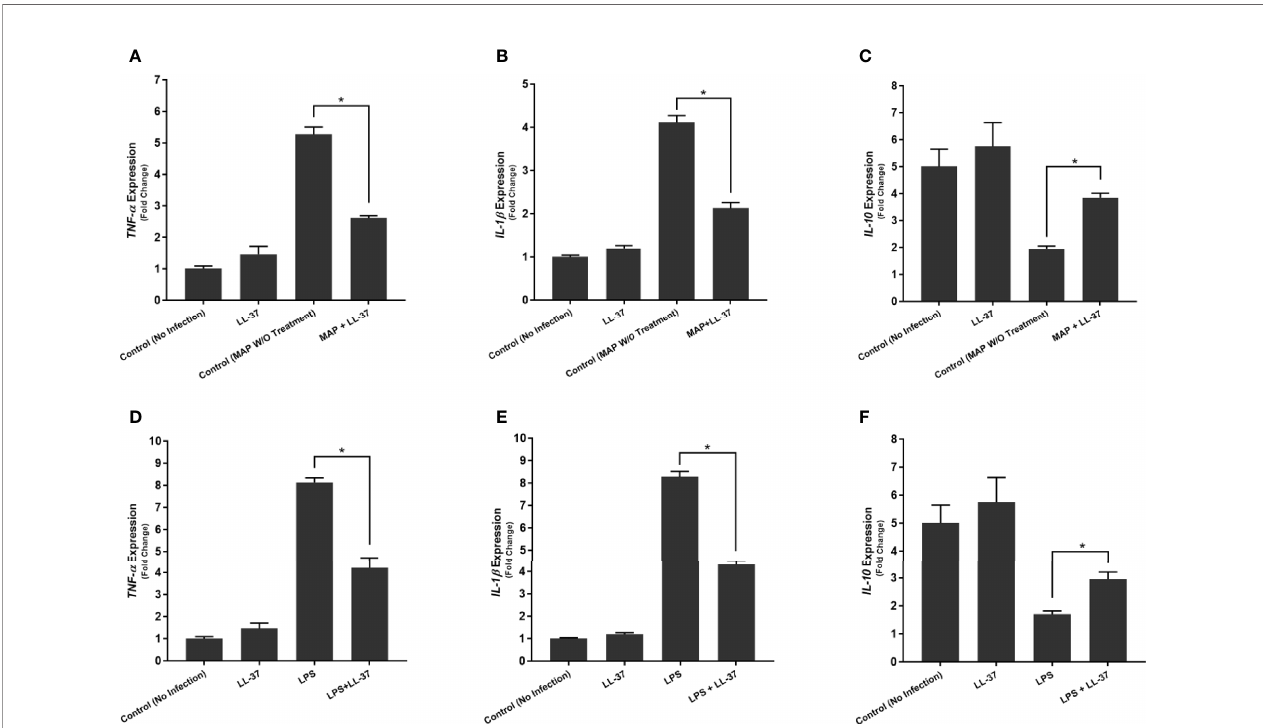
FIGURE 5 | Effects of LL-37 treatment on the expression of TNF- a (A, D) , IL-1 b (B, E) , and IL-10 (C, F) in MAP-infected (A – C) and LPS-stimulated (D – F) macrophages. Relative expression was quanti fi ed using RT-qPCR. *Indicates P-value of less than 0.05.